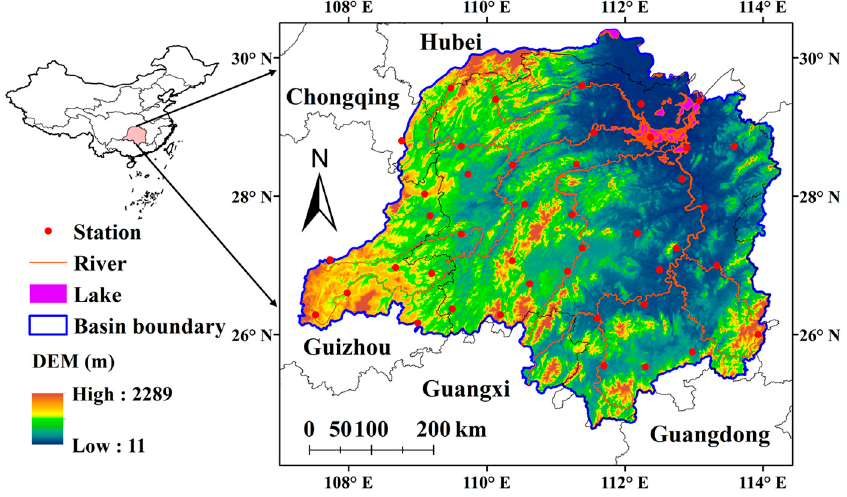
Figure 1. The topographical map and distribution of the meteorological stations in DTLB.